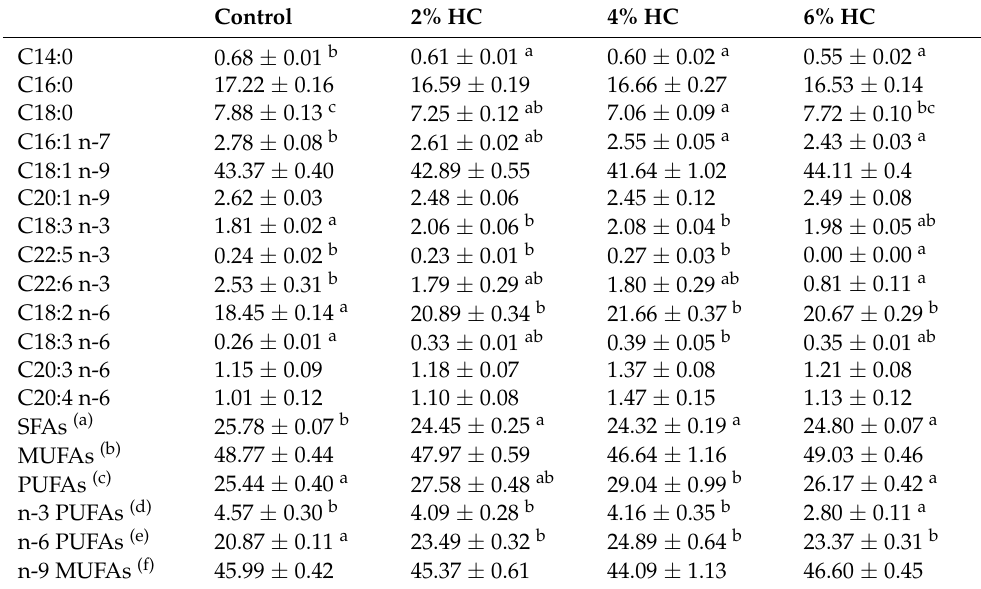
Values are presented as mean ± SE ( n = 3). Different superscript letters of peers indicate significant differences ( p < 0.05). (a) SFAs: Saturated fatty acids (C14:0, C16:0, C18:0). (b) MUFAs: Monounsaturated fatty acids (C16:1